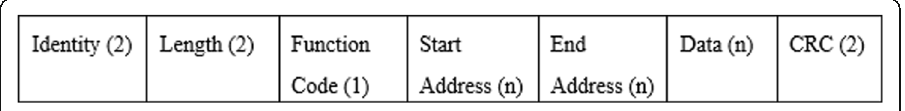
Fig. 5 An example of industrial Internet protocol input